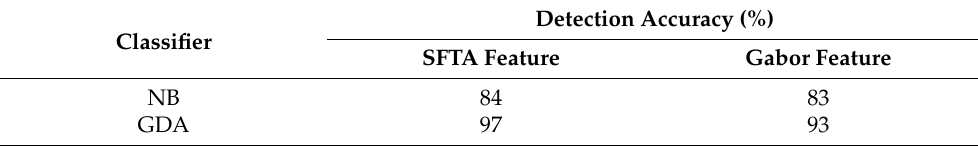
Table 3. Detection Accuracy Rate of two classifiers on two features across MaleVis